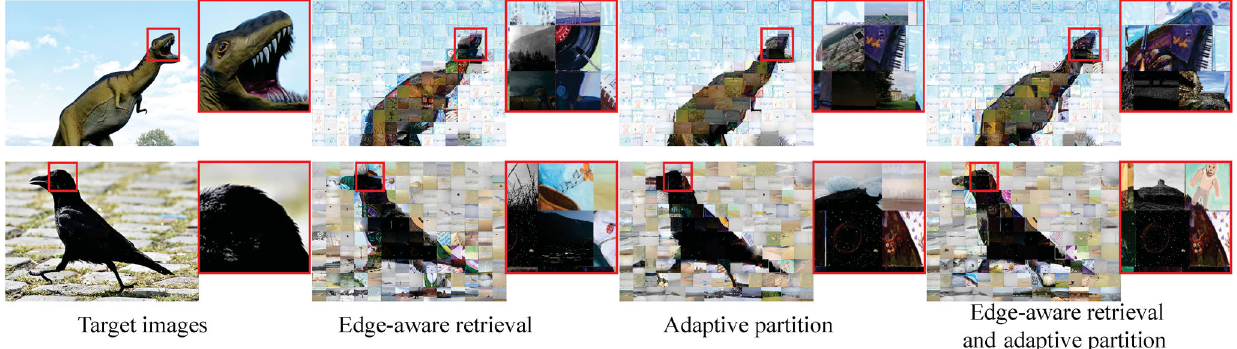
Fig. 5 Comparison between our method and simplified versions, showing the importance of both components of our algorithm for generating good image